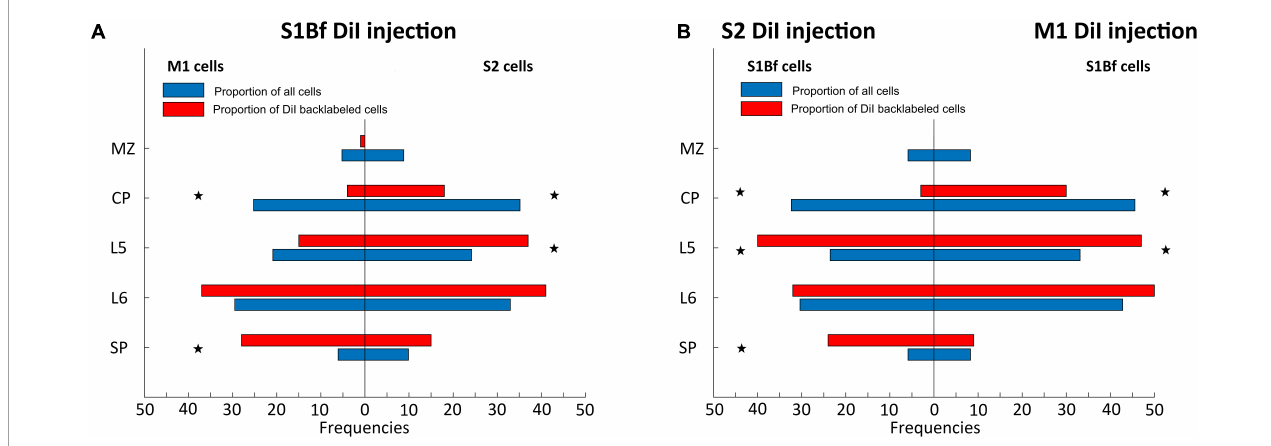
FIGURE4 Statistical comparison of observed proportions of DiI backlabeled cell with the proportion of all neurons across cortical layers. (A) Proportions of backlabeled and all neurons within M1 (left panel) and S2 (right panel) on S1Bf injected samples. (B) Proportions of backlabeled and all neurons within S1Bf upon S2 (left panel) and M1 (right panel) injections. Asterisks indicate if the observed proportion of back-labeled cells differs significantly ( p > 0.05) from the proportion of neurons in the respective